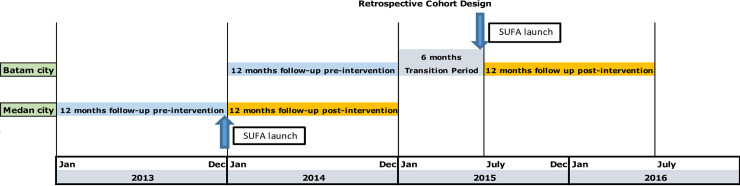
Retrospective study design of Pre and Post-SUFA intervention periods for the Medan and Batam cities.Two Pre-SUFA data and two Post-SUFA data periods were included. Each period and each city included follow-up for 12 months. The pre-SUFA intervention in Medan was for 26 Dec 2012–25 Dec 2013 and post-SUFA for 26 Dec 2013–25 Dec 2014. Pre-SUFA intervention in Batam was from 26 Dec 2013–25 Dec 2014 and post-SUFA 26 June 2015–25 June 2016.